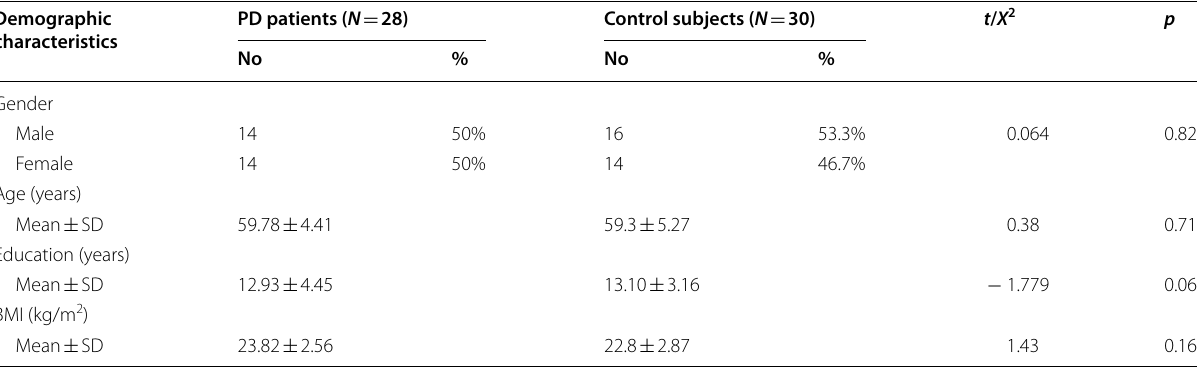
Table 1 Demographic data among PD patients and control subjects